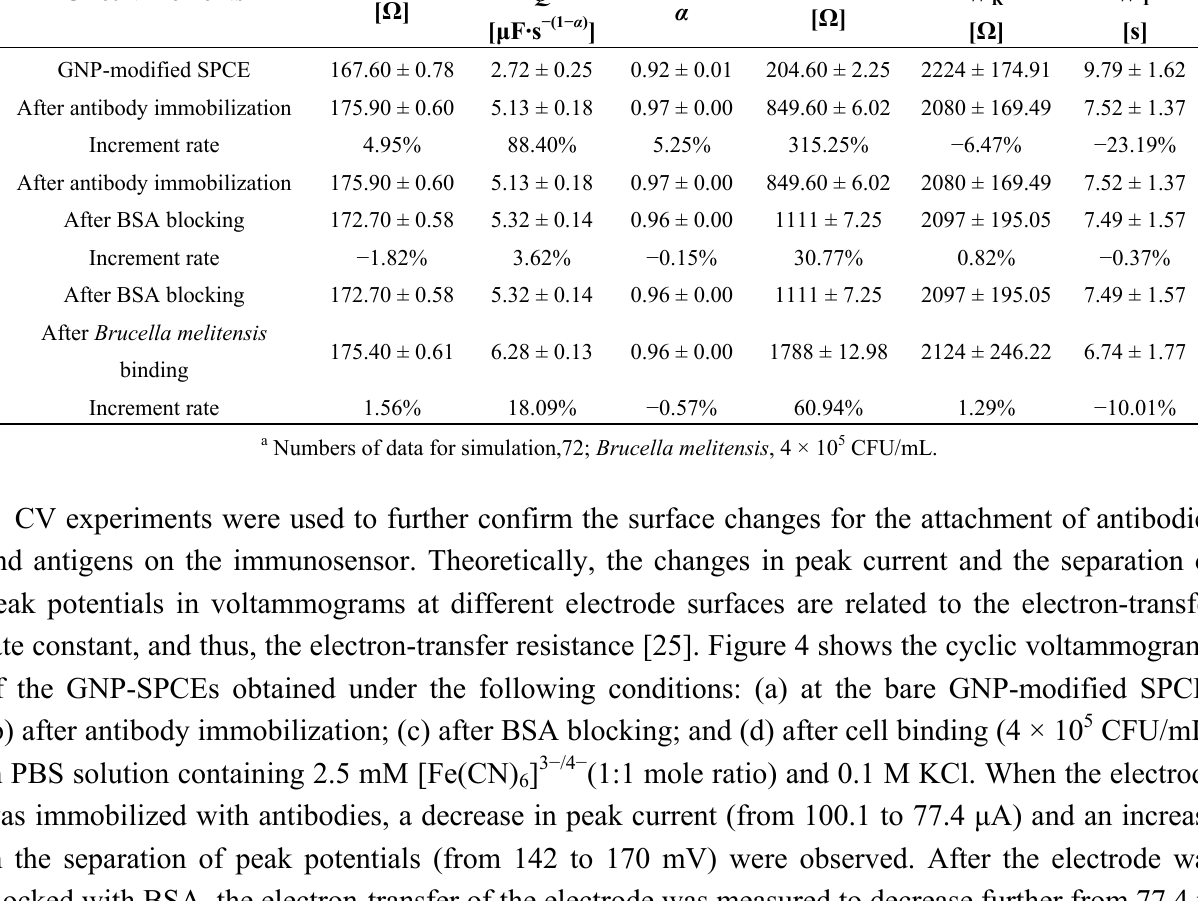
Table 1. Simulated values of all elements in the equivalent circuit and percentage of their changes a . Circuit